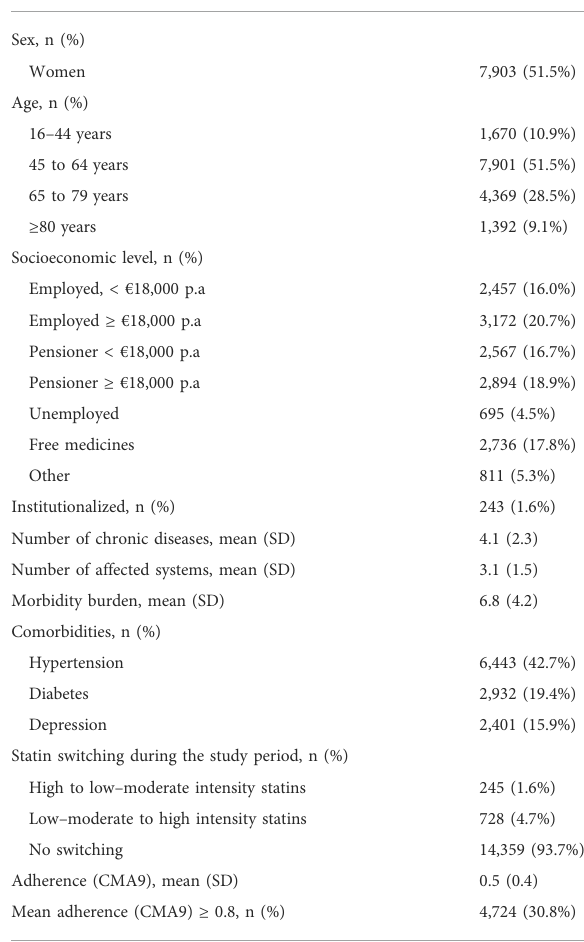
TABLE 1 Characteristics of the study